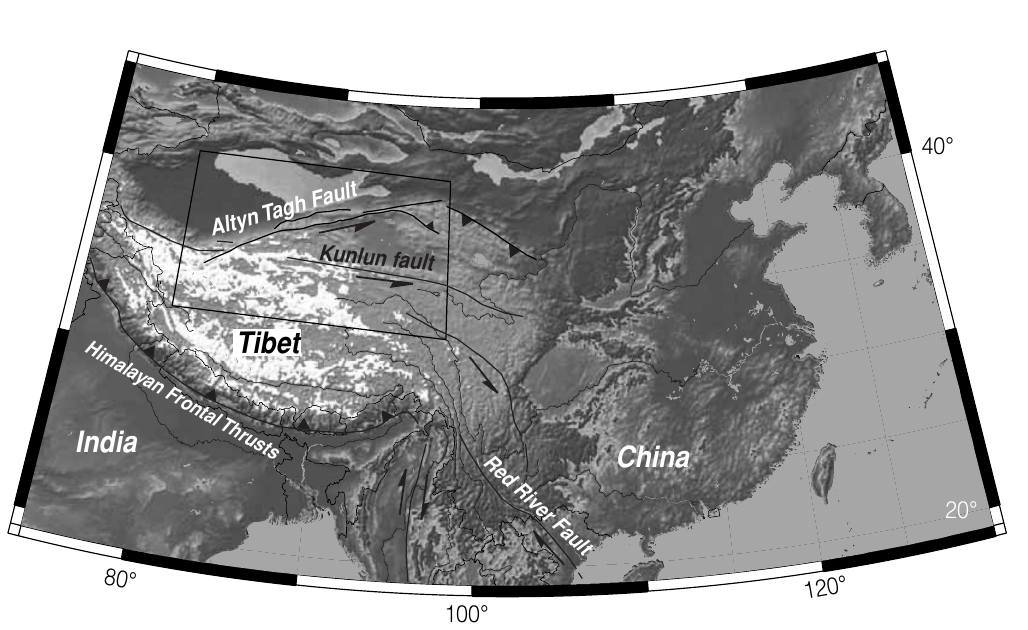
Fig. 1. Overview map showing major structures and topography in the India-Eurasia continental collision zone. Inset shows location of fig. 2. Figure generated from GTOPO30 1 km digital elevation data set using GMT (Wessel and Smith,